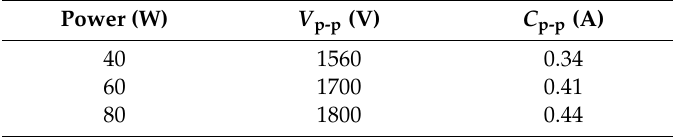
Table 1. The input voltage and current of different discharge powers.